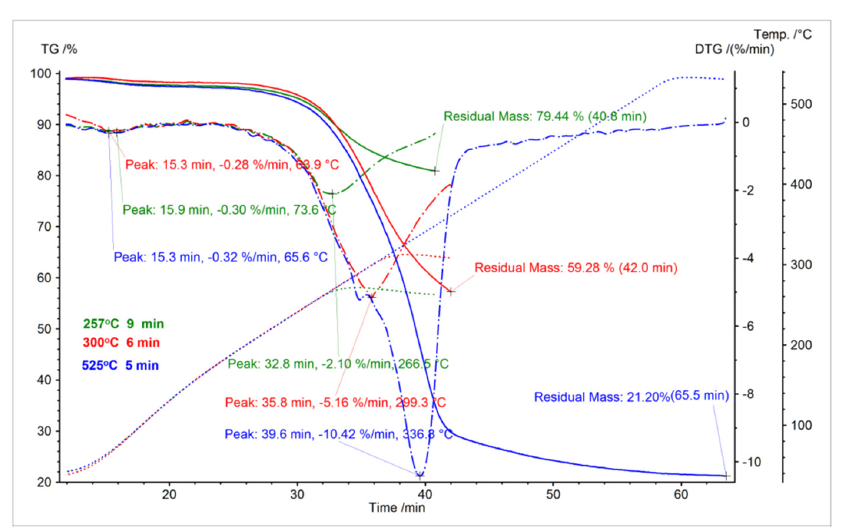
Figure 11. Analyses of Miscanthus mass loss with DTG curves during the torrefaction process.